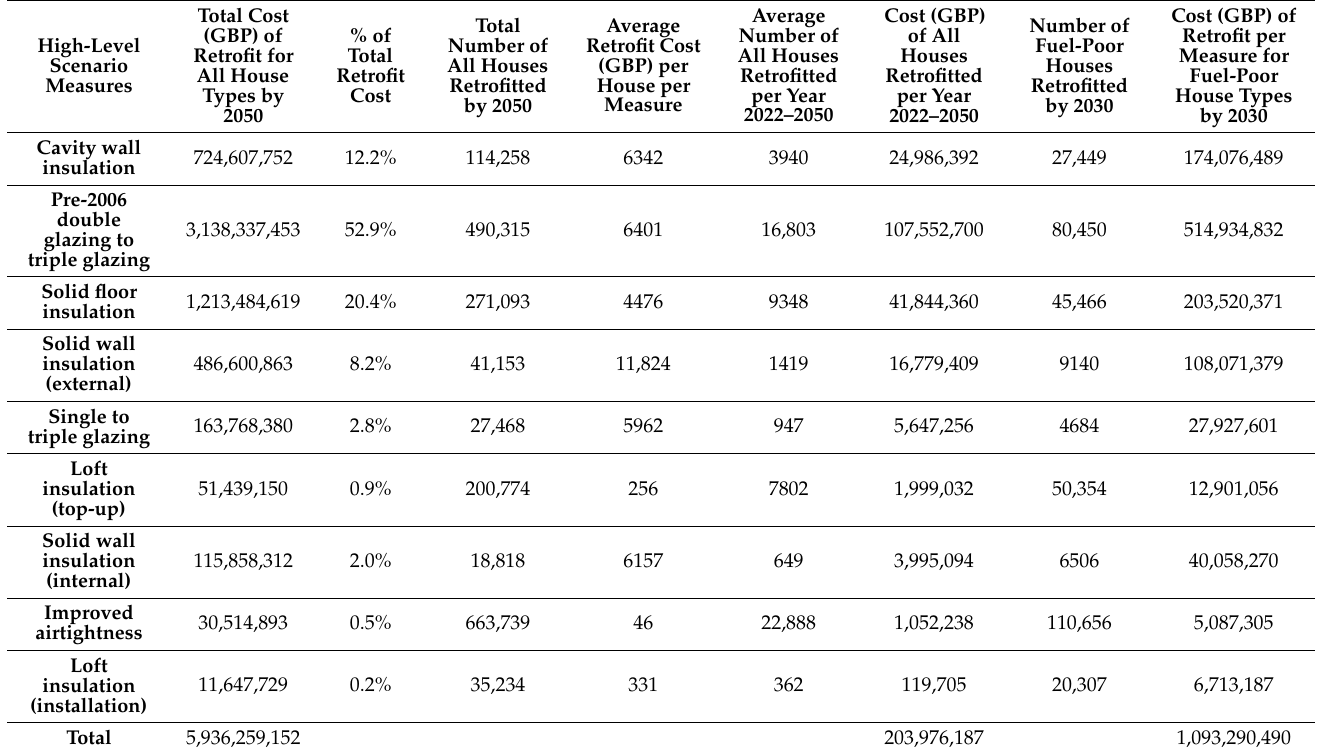
Table 6. Retrofit cost breakdown for the High-Level